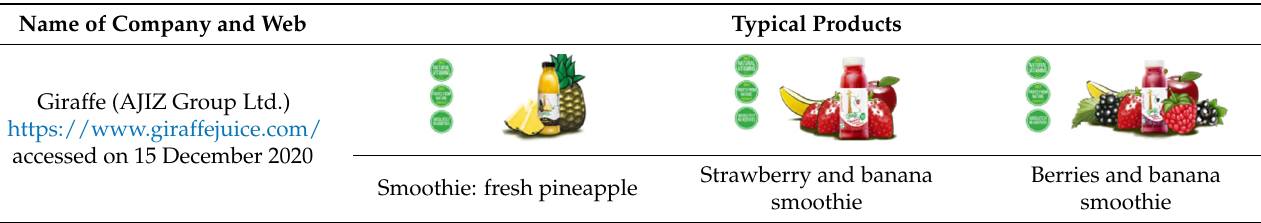
Table A7. High pressure treated products by the company Giraffe (AJIZ Group Ltd.).